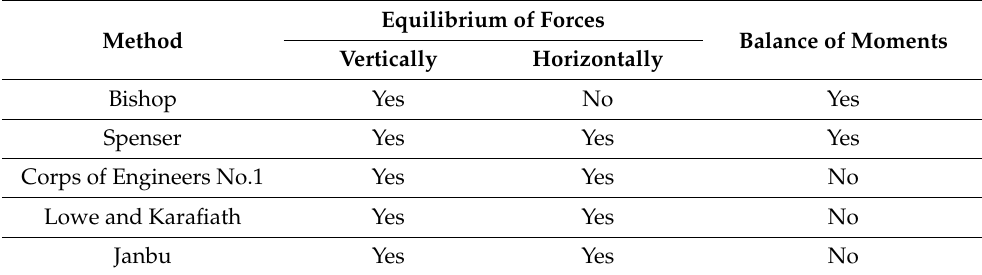
Table 1. Methods of calculating the stability of the slope and static equilibrium conditions. Equilibrium of Forces Method Balance of Moments Vertically